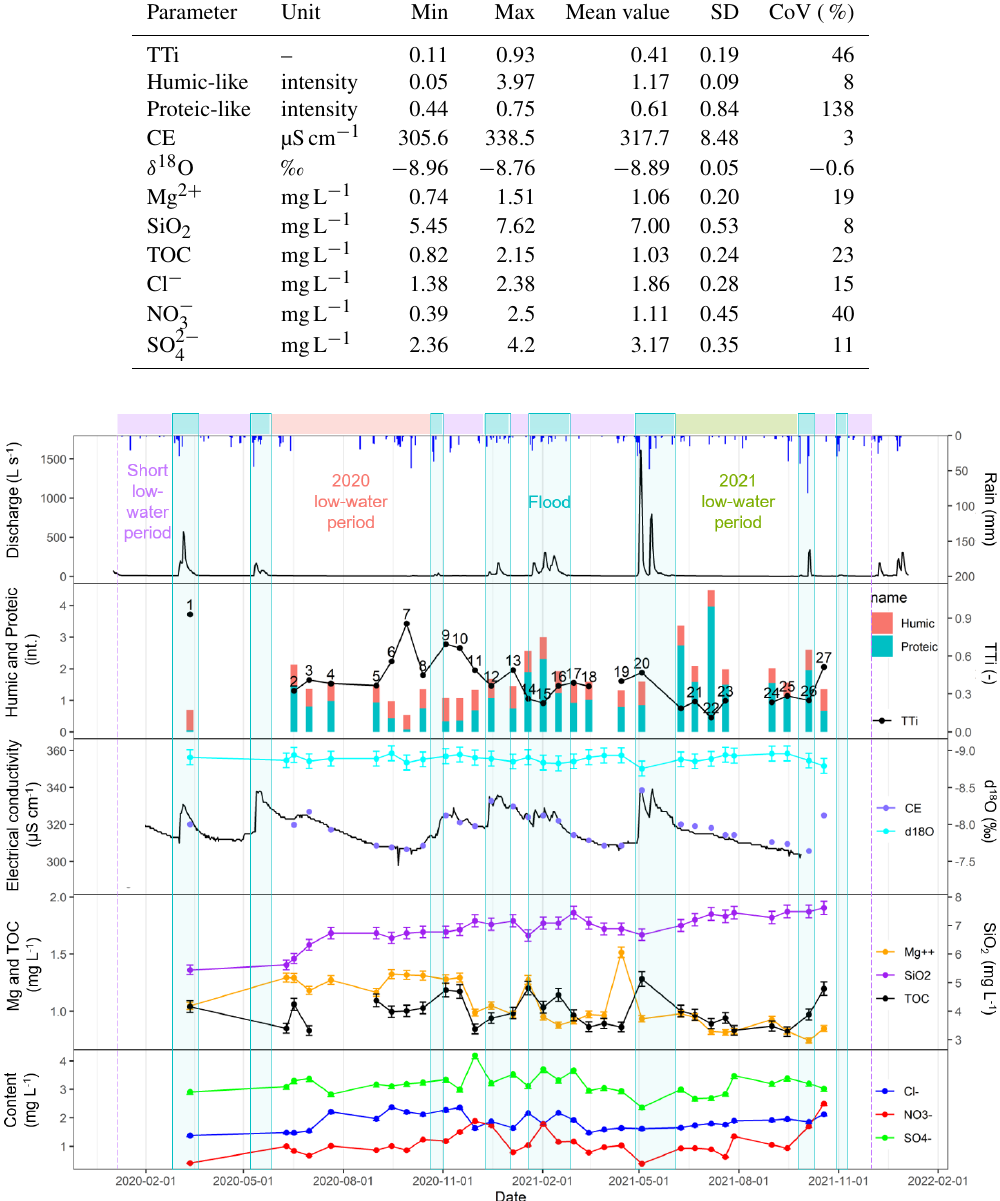
Figure 4. Millet spring time series of rain, discharge (Mazzilli et al., 2022), TTi, humic-like (component 1) and protein-like (sum of compo- nents 2, 3 and 4) fluorescent organic matter, continuous and punctual electrical conductivity, δ 18 O, p CO 2 , and magnesium, silica, chloride, nitrate, and sulfate contents over the period from June 2020 to October 2021. Colors above the discharge plot and numbers on the TTi curve correspond to Fig.